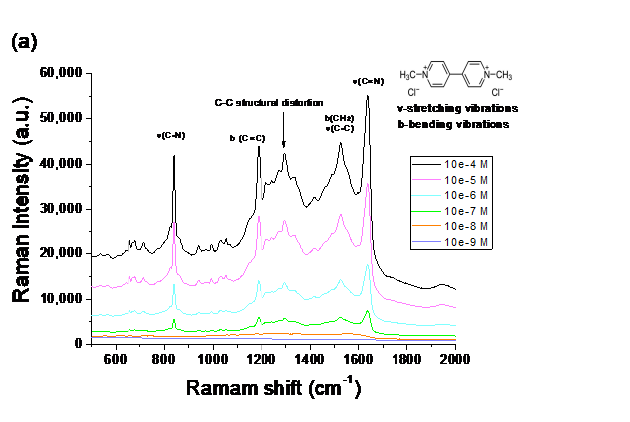
Figure 11. The Raman spectra from the SERS Sample C with various ( a ) paraquat and ( b ) acetylcholine analyte concentrations.